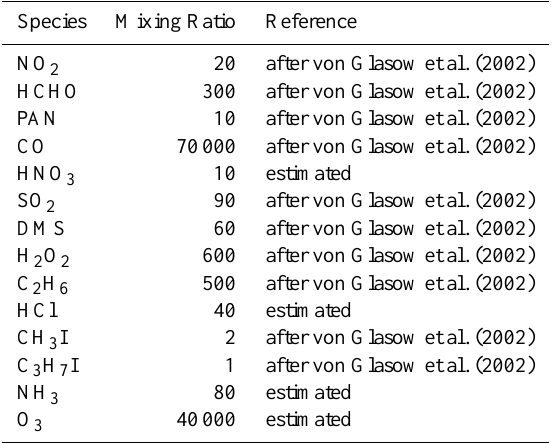
Table 2. Initial gas-phase chemical mixing ratios (given in pmolmol − 1 ).